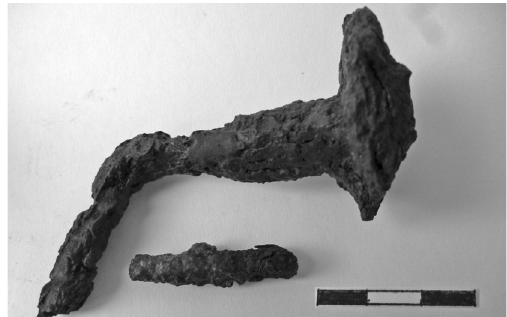
Figure 8: Carbonara Scrivia, tomb no. 1. A bent-over nail from the restriction system (photo Enrico Bertazzoli © Soprintendenza Archeologia del